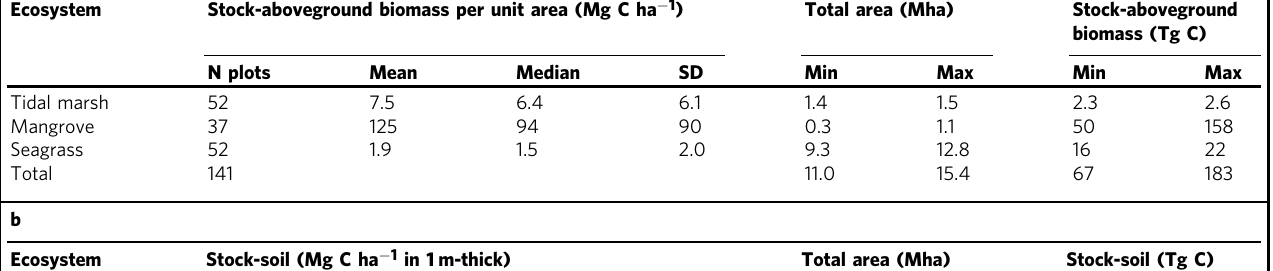
Fig. 1 . Distribution of climate regions, vegetated coastal ecosystems (tidal marshes, mangroves and seagrasses) and organic carbon (C) storage in